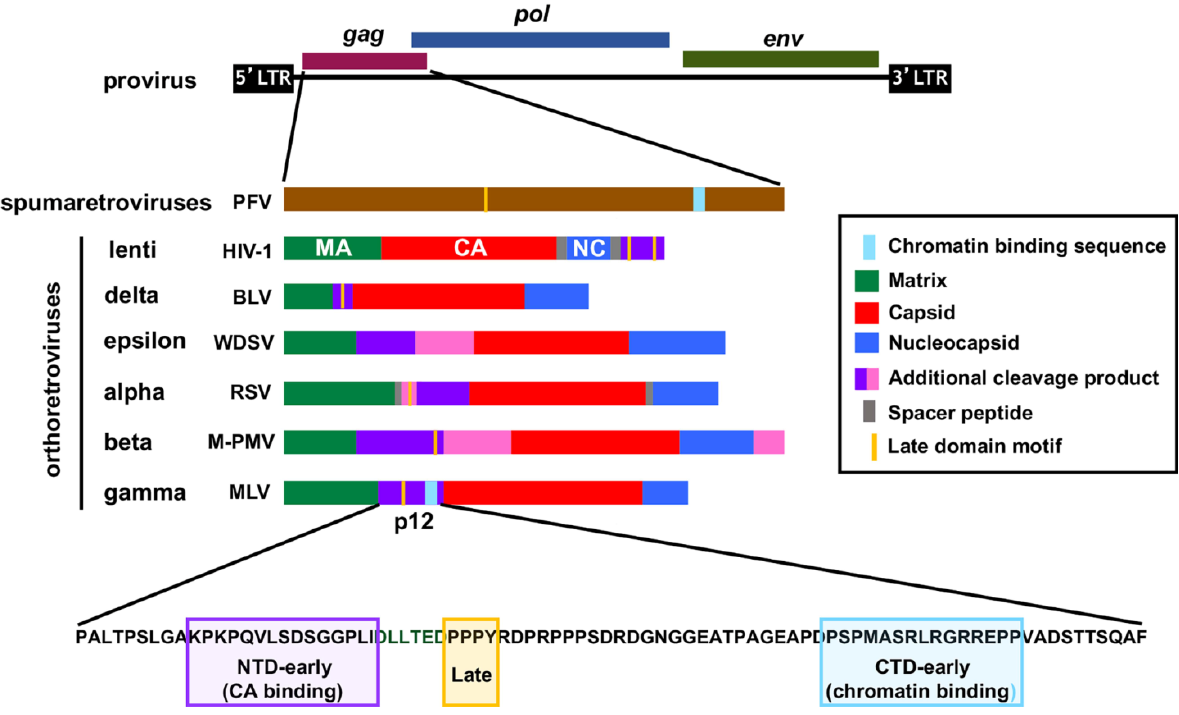
FIGURE 1: Schematic representation of retroviral Gag proteins. All retroviruses encode three main genes: gag, pol and env. The gag gene codes for the structural proteins of the virus. It is translated into a polyprotein that is then cleaved during viral maturation in orthoretrovi- ruses into individual proteins as indicated in the key: matrix (MA, green); capsid (CA, red); nucleocapsid (NC, blue) and additional small proteins (purple and pink). The Gag protein of spumaretroviruses is not cleaved, shown in brown. The position of proline-rich late domain motifs which recruit the ESCRT pathway to facilitate viral release in late replication are indicated in yellow. The identified chromatin bind- ing motifs are shown in light blue. The p12 amino acid sequence from the gammaretrovirus Mo-MLV is given, highlighting the motif in the NTD responsible for CA binding (in purple) and the CTD chromatin binding motif (in light blue). Abbreviations: PFV, prototypic foamy virus; HIV, human inmmunodeficiency virus; BLV, bovine leukemia virus; WDSV, walleye dermal sarcoma virus; RSV, Rous sarcoma virus; M- PMV, Mason Pfizer Monkey virus; MLV, murine leukemia